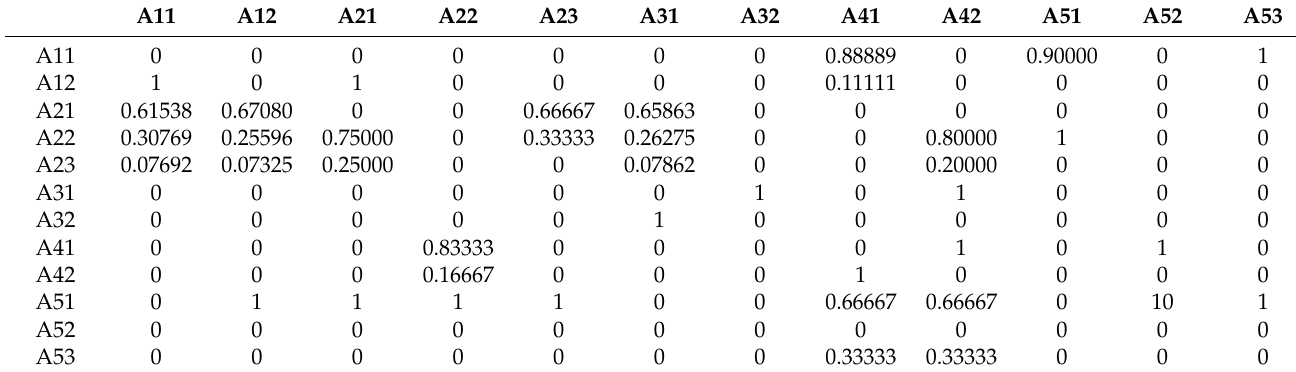
Table 6. The unweighted hypermatrix.